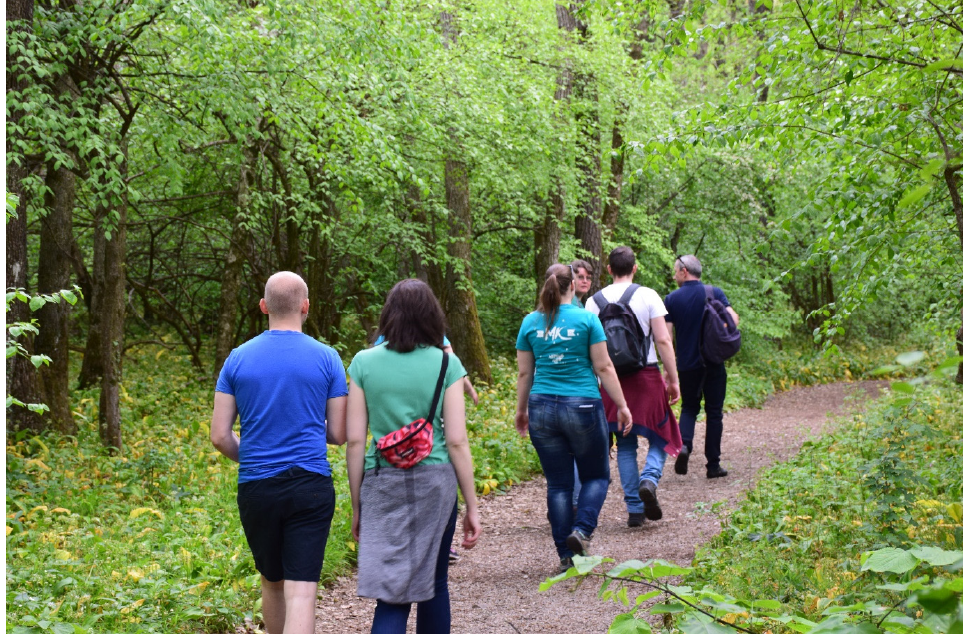
Figure 2. Participants walking on the tourist route in May.